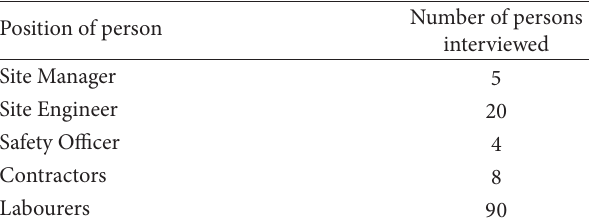
Table 1: Interview details. Table 2: Total number of workers in small and large